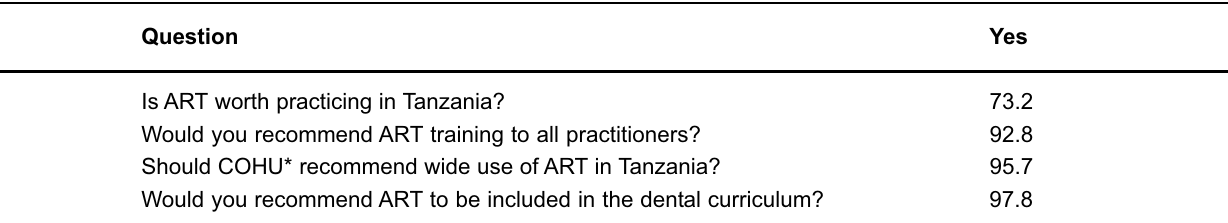
TABLE 3- Percent distribution of positive responses given by 138 Tanzanian dental practitioners to 4 questions regarding the introduction of ART in Tanzania